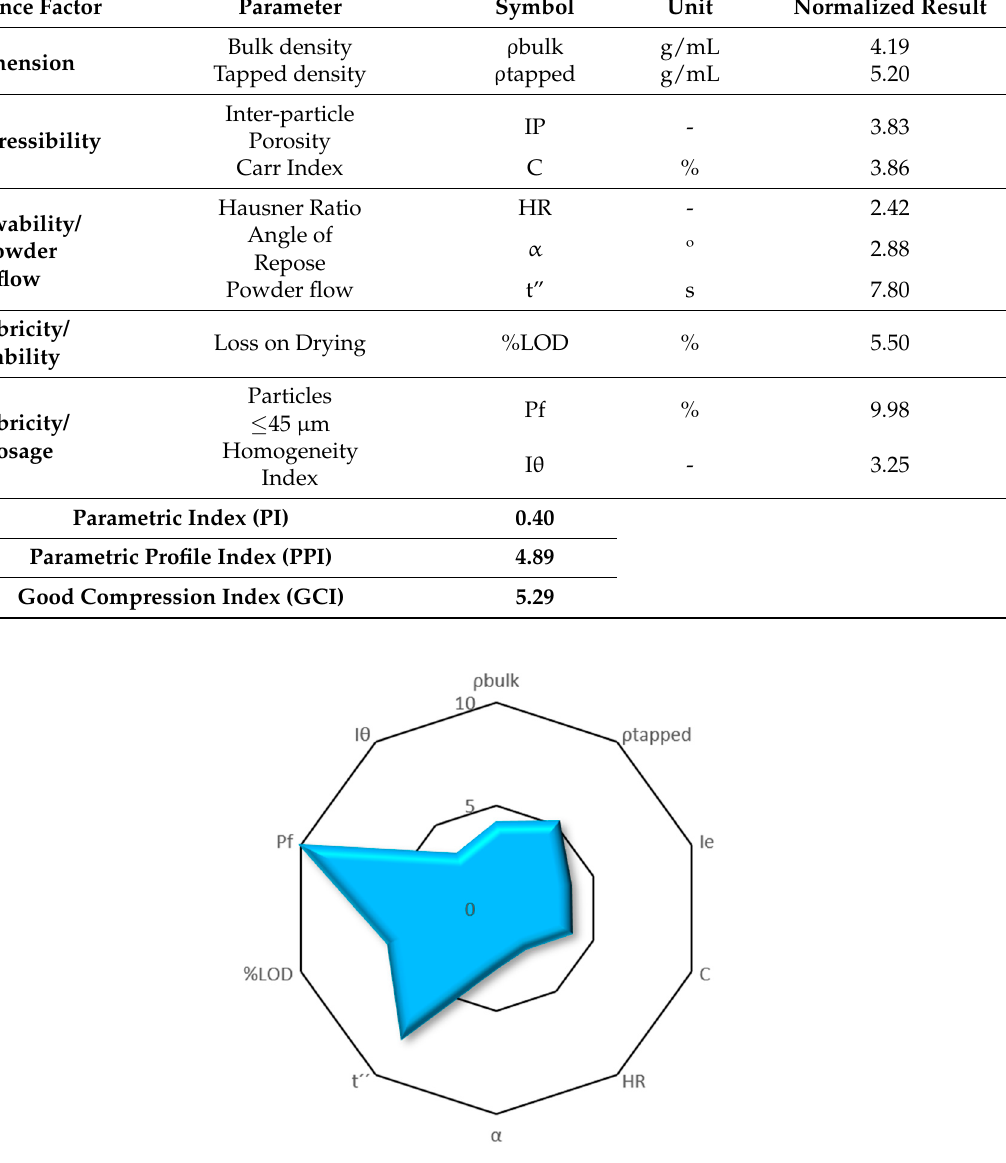
Figure 4. SeDeM diagram of PBS_CL.